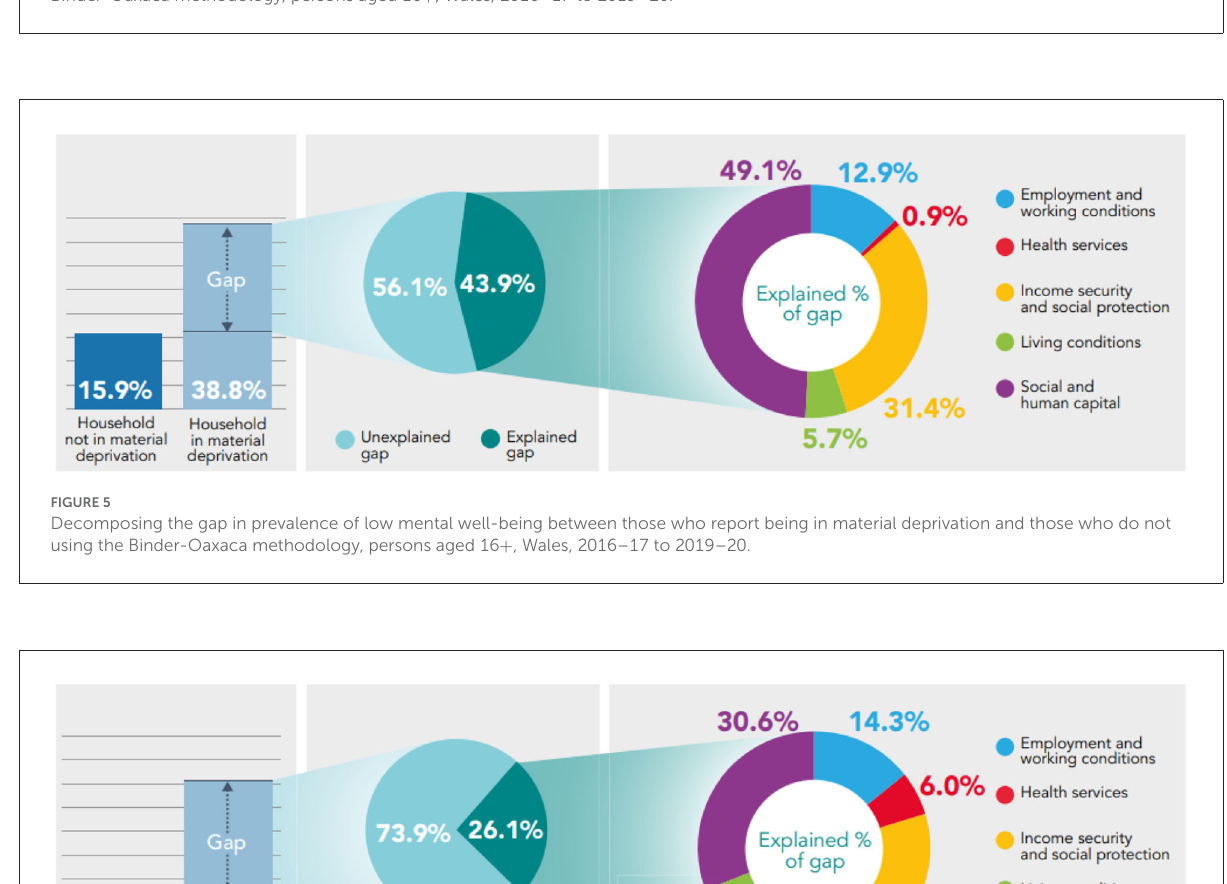
FIGURE4 Decomposing the gap in prevalence of fair/poor health between those who report being in material deprivation and those who do not using the Binder-Oaxaca methodology, persons aged 16 + , Wales, 2016–17 to 2019–20.